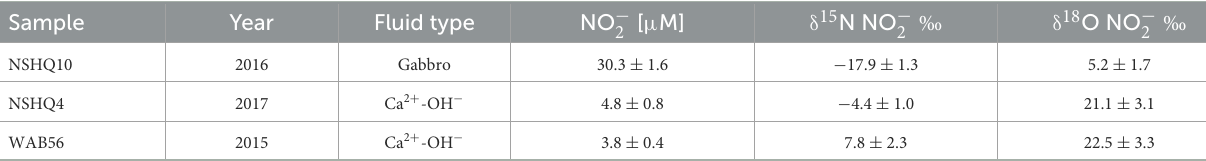
TABLE 4 δ 15N and δ 18O of NO − 2 with NO − 2 concentration measured by mass balance by the denitrifier method after NO − 2 removal with sulfamic acid. Sample